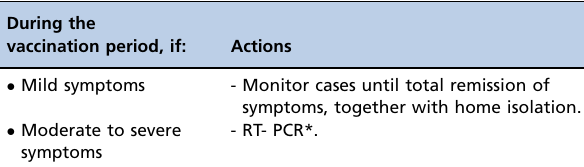
Table 1 - Recommendations for the surveillance of symptomatic professionals in health services (that serve patients with COVID-19) during the SARS-CoV-2 vaccination